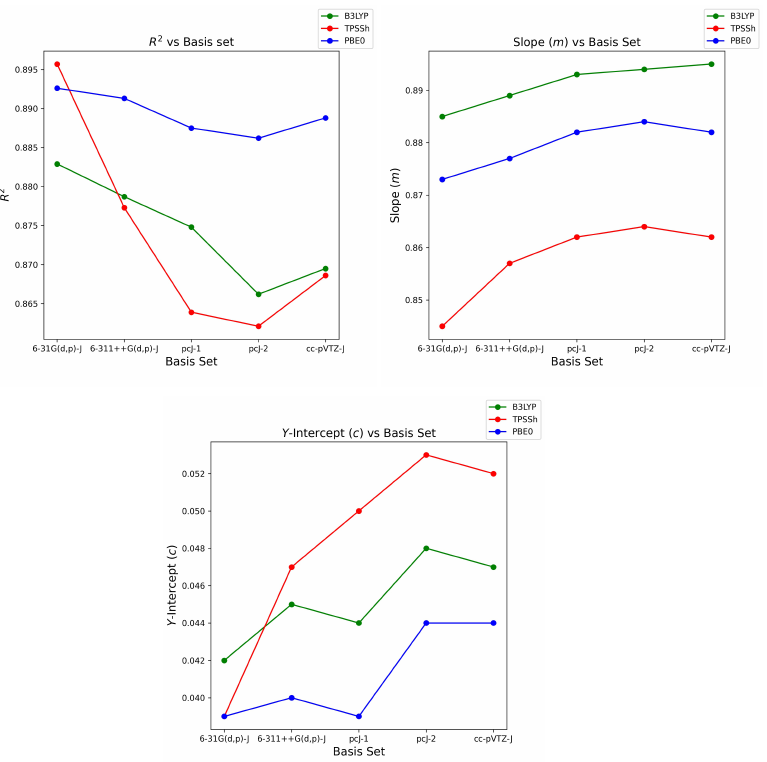
Figure 4. Trend in R 2 , slope ( m ) and y -intercept ( c ) parameters transitioning along each basis set for B3LYP, TPSSh and PBE0 functionals